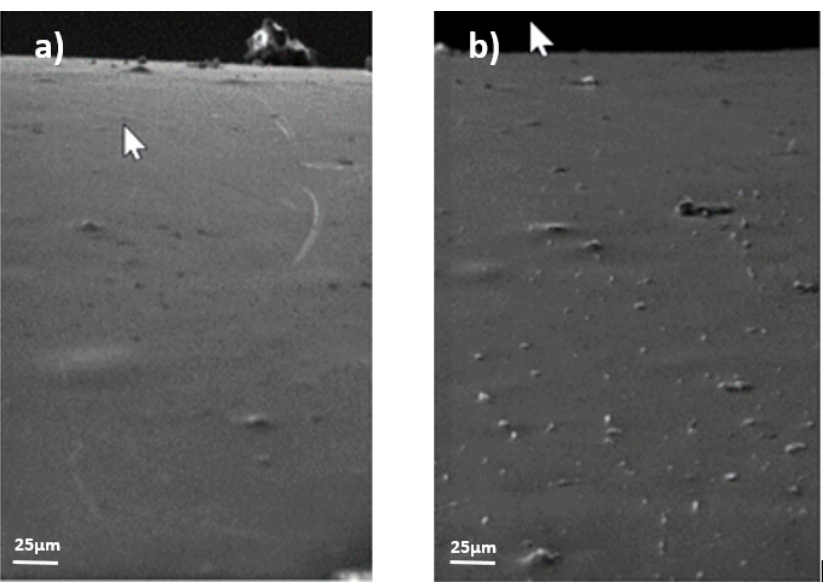
Figure 11. Example of surface evolution in acid zinc electrolyte coating (sample 3) without stresses (R); ( a ) month 1, ( b ) month 9.